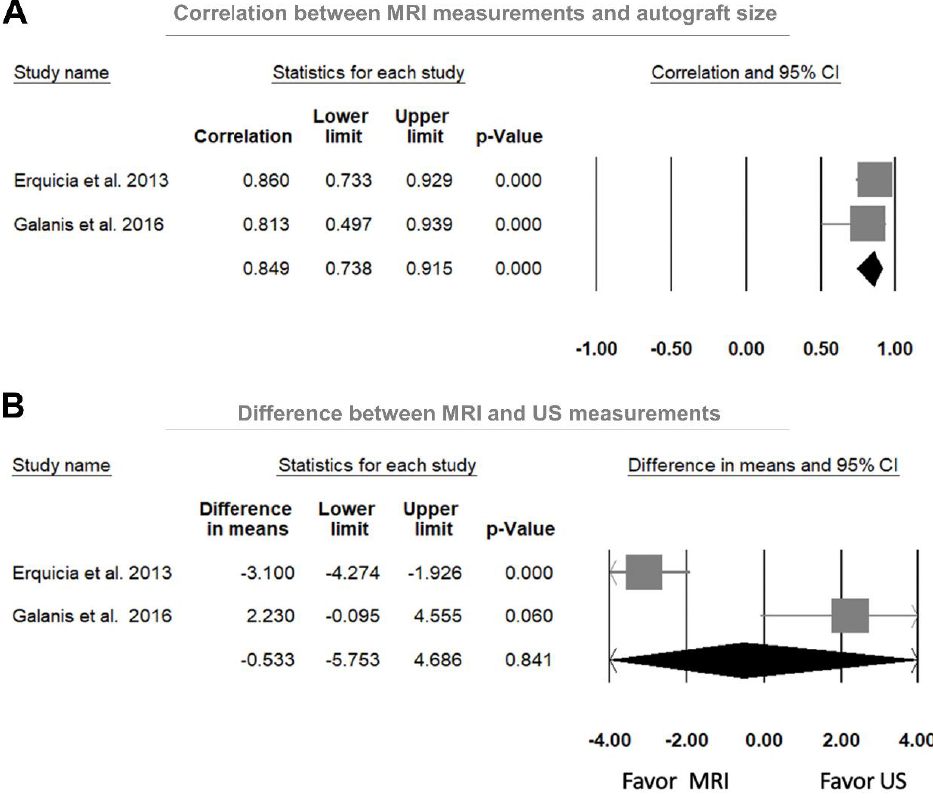
Figure 4. Forest plots of ( A ) the correlations between the magnetic resonance imaging (MRI)-measured cross-sectional area (CSA) and the intra-operative graft diameter and ( B ) the weighted mean difference between the MRI-measured and the ultrasound (US)-measured CSA. CI, confidential in- terval.